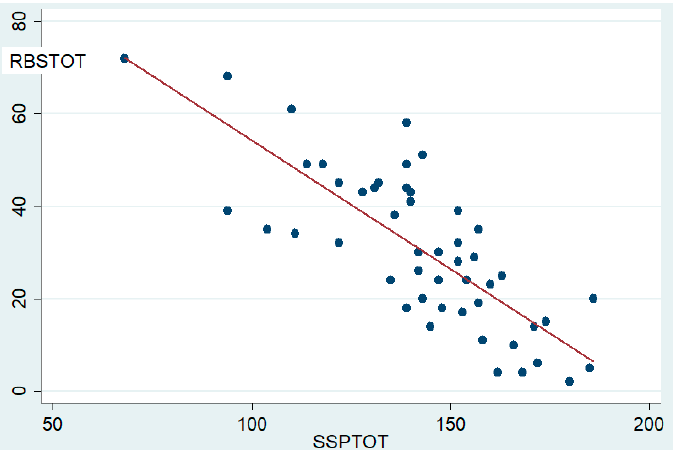
Figure 1. Correlation between sensory profile and repetitive behaviours. Legend: The scatter plot shows the linear correlation, with a low dispersion grade, between SSP total scores (SSP-TOT) and RBS-R total scores (RBS-TOT).